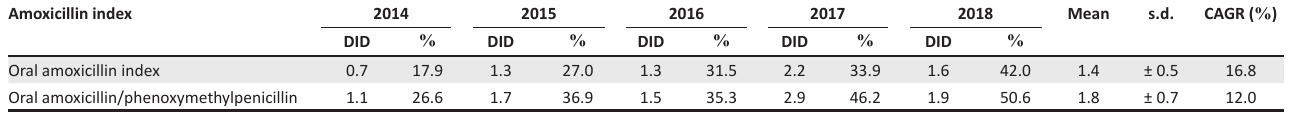
TABLE 3: Absolute and relative amoxicillin index. Amoxicillin index